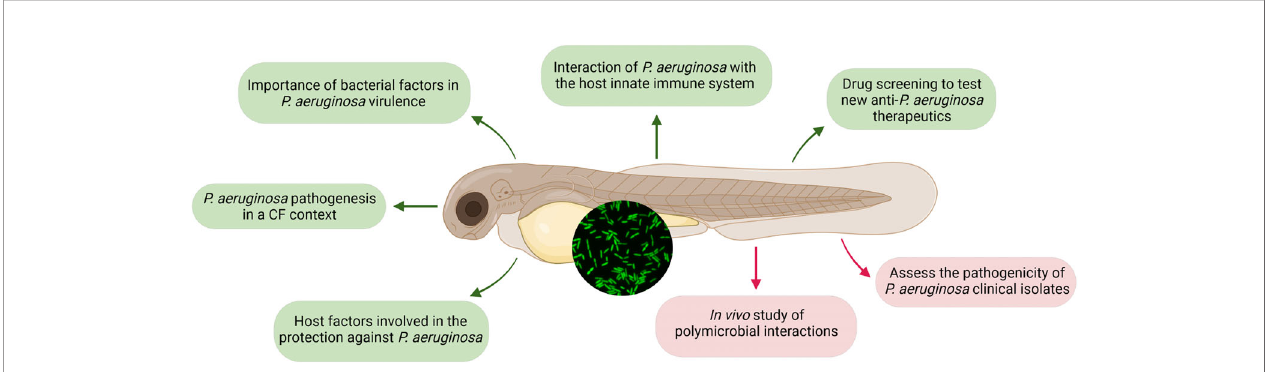
FIGURE 3 | Insights from infecting zebra fi sh embryo with Pseudomonas aeruginosa (GFP-expressing bacteria are shown in the inserted picture). Insights presented in this review, using diverse infection routes, are represented in green, while new appealing perspectives that are clinically relevant are highlighted in red. Created with